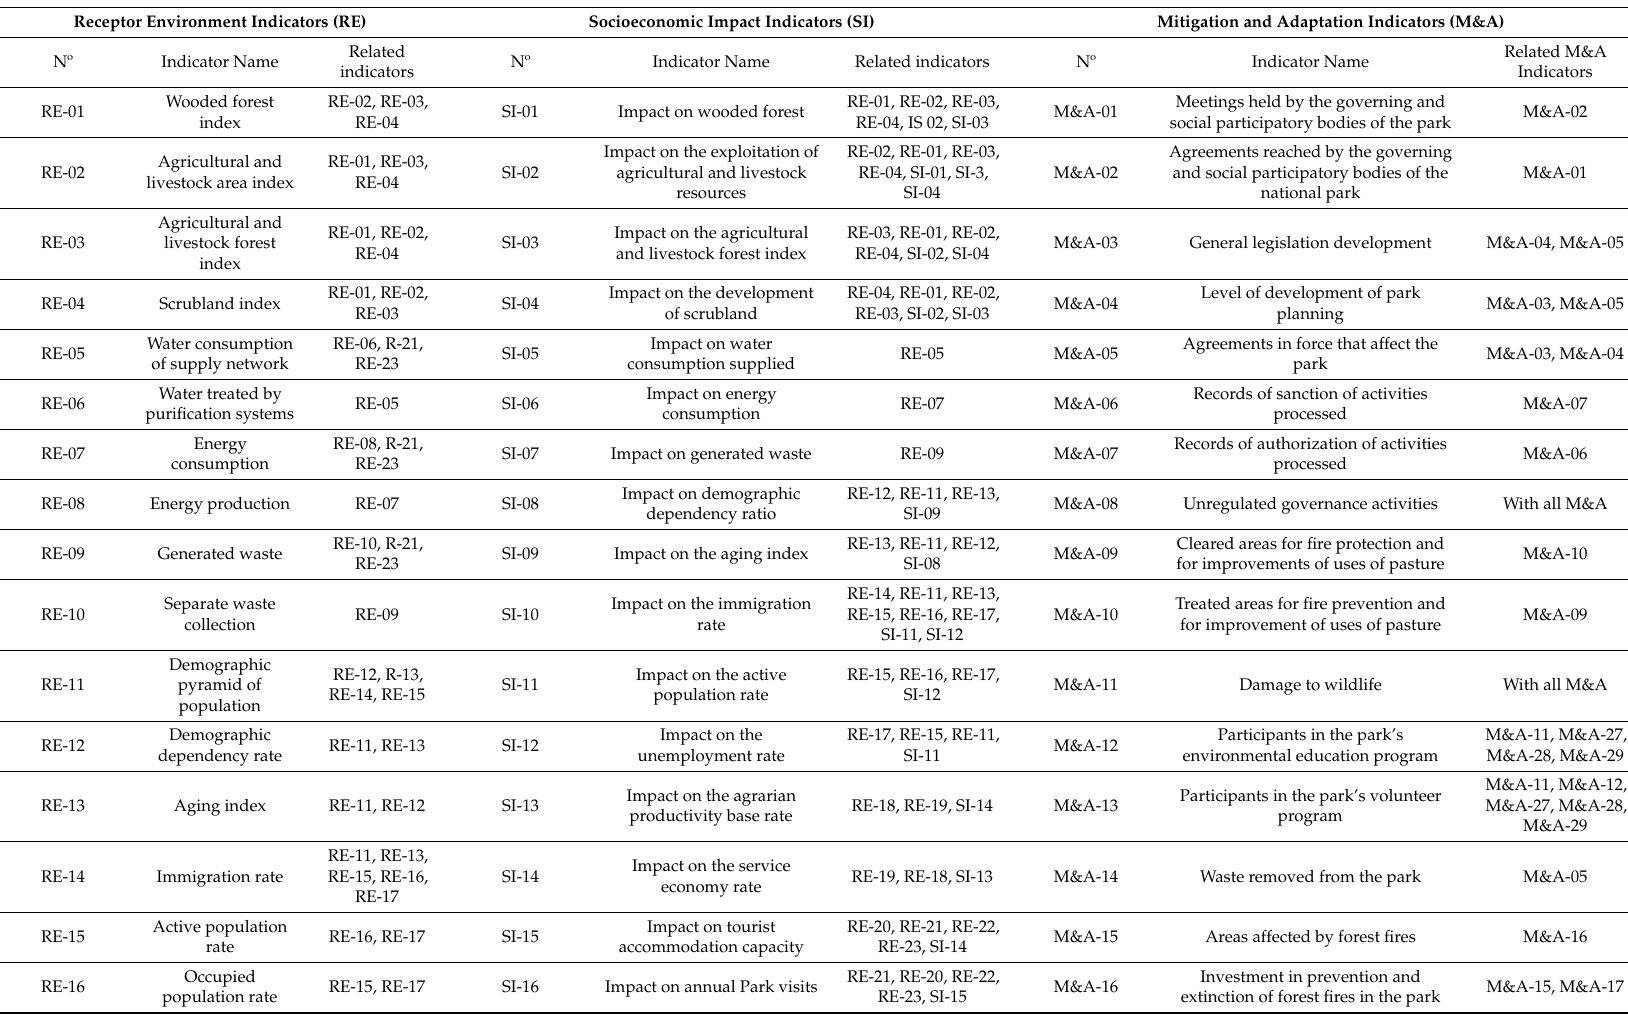
Table 2. Indicators for the Socio-Economic Monitoring and Evaluation System of Climate Change of the Sierra de Guadarrama National